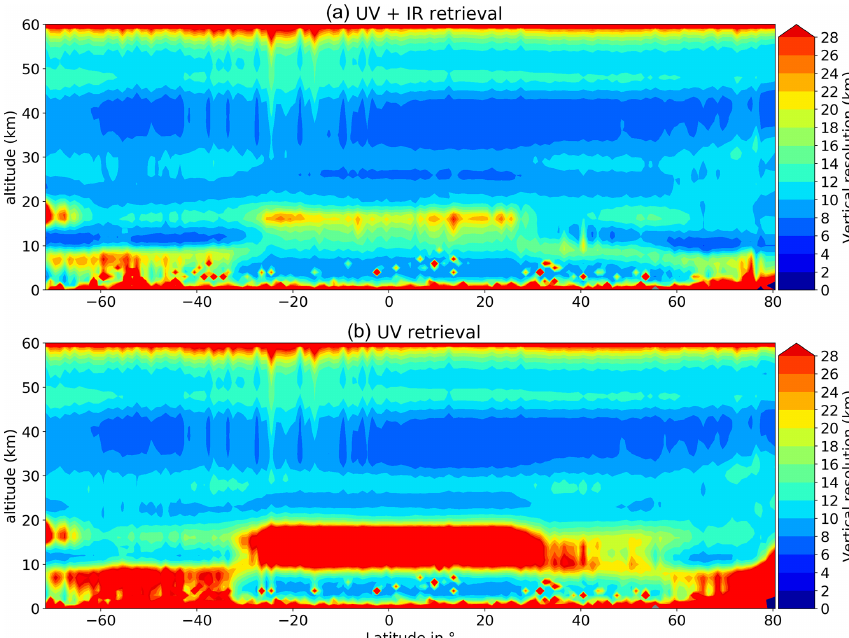
Figure 12. Zonally averaged vertical resolution for 1d of TOPAS retrieval data (1 October 2018). The vertical resolution is given by the inverse main diagonal elements of the AK matrix. (a) Vertical resolution for the combined retrieval. (b) Vertical resolution from the UV-only